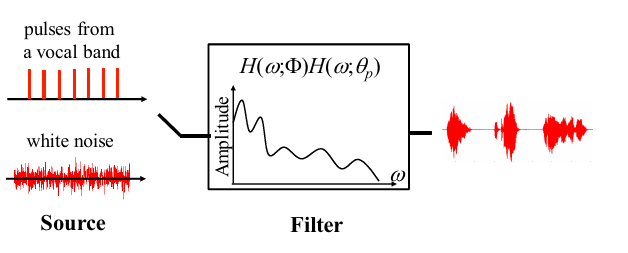
Figure 3. Source filter model of human voice